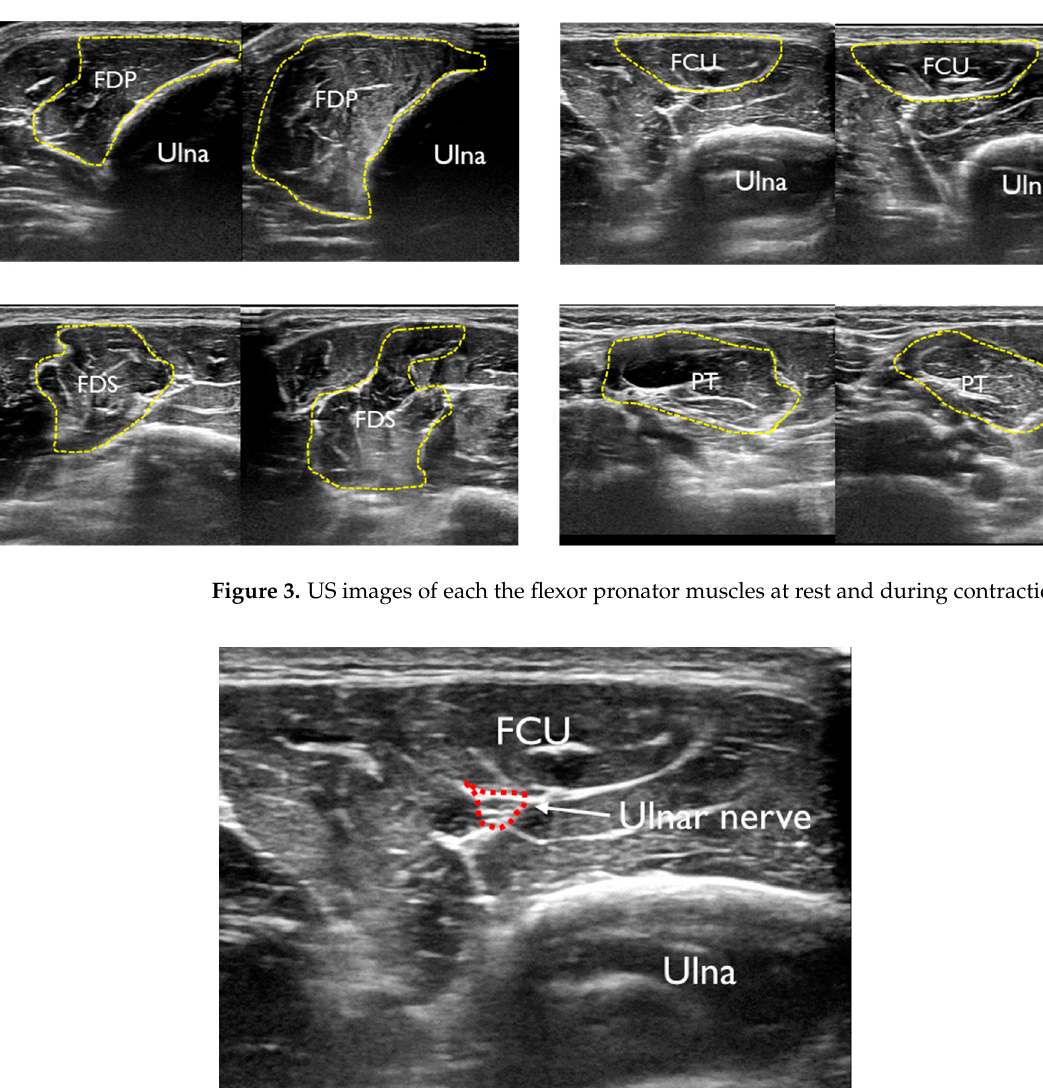
Figure 4. US image of ulnar nerve2.5. Statistics.